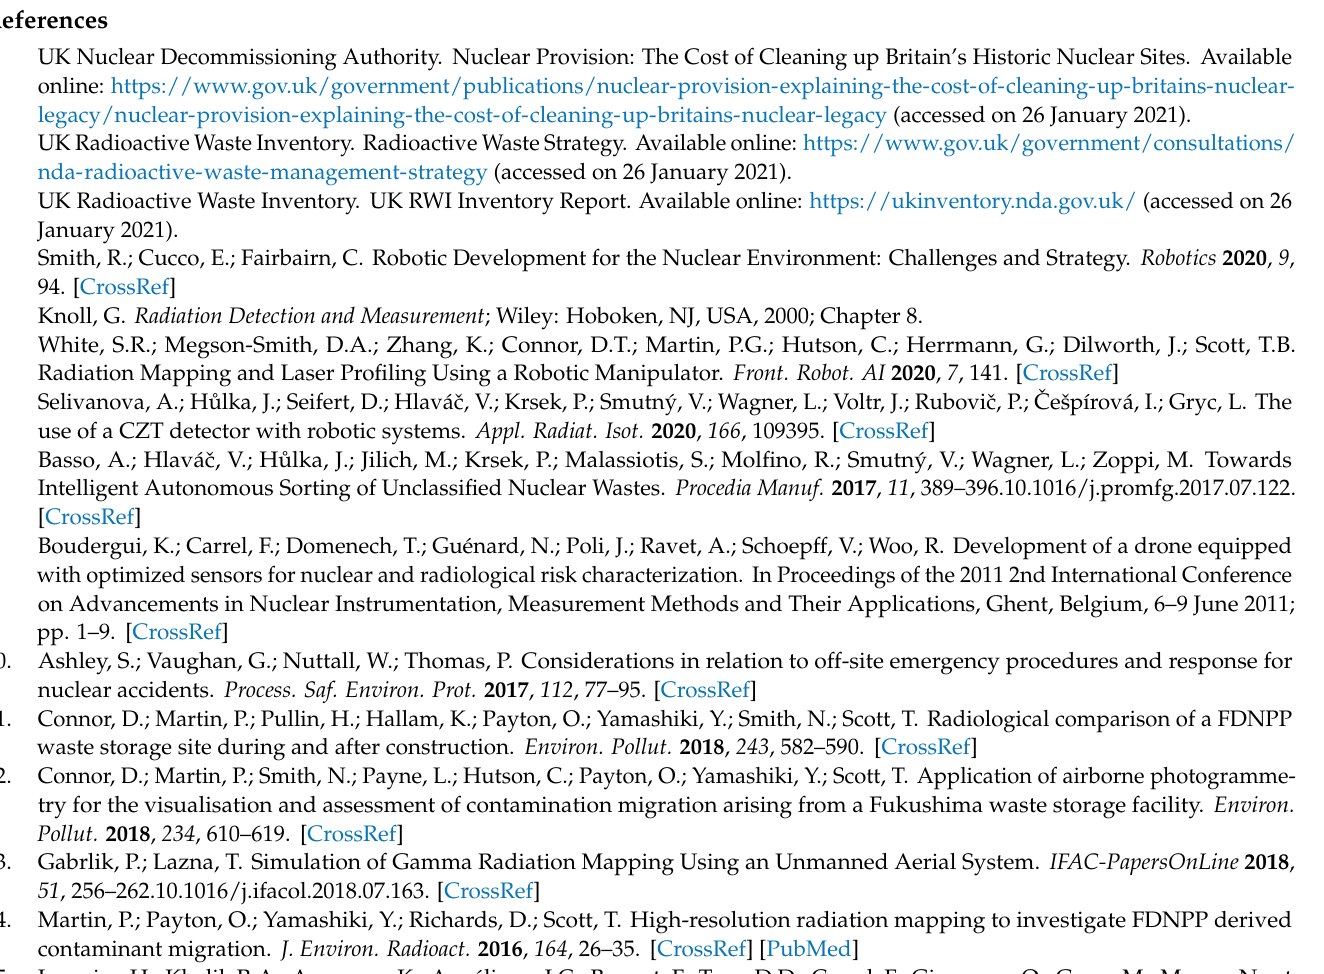
Figure A4. A schematic diagram showing the physical locations of the sources used for scenario 4. The NORM sources are shown in orange and the Cs-137 in